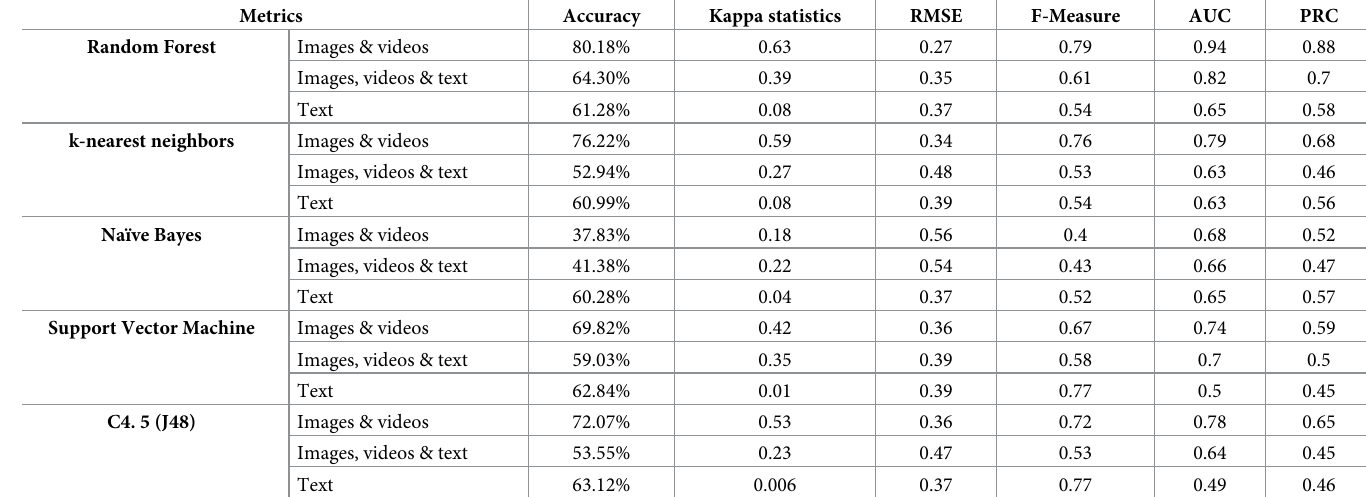
Table 4. Different classifier results for model accuracy, Kappa statistics, RMSE, F-measure, Area under Curve (AUC) and Precision Recall Curve (PRC).